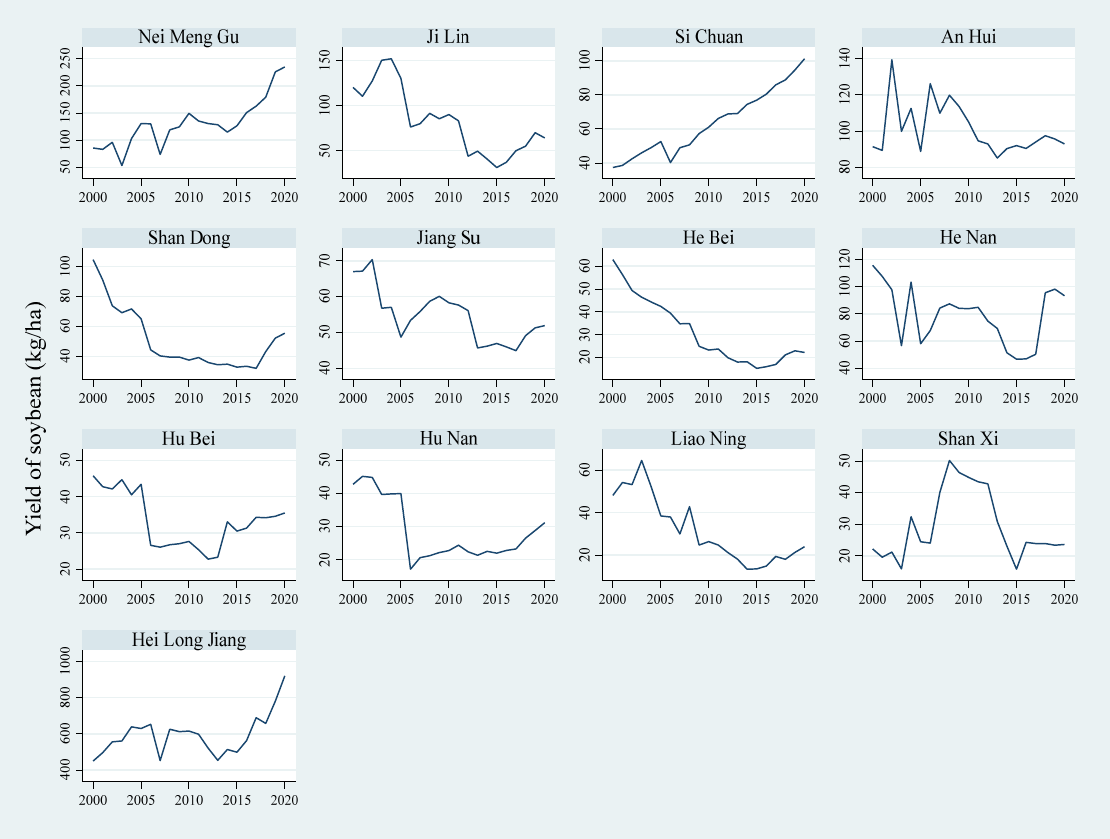
Figure 1. Major soybean-producing provinces of China, trends from 2000 to 2020.